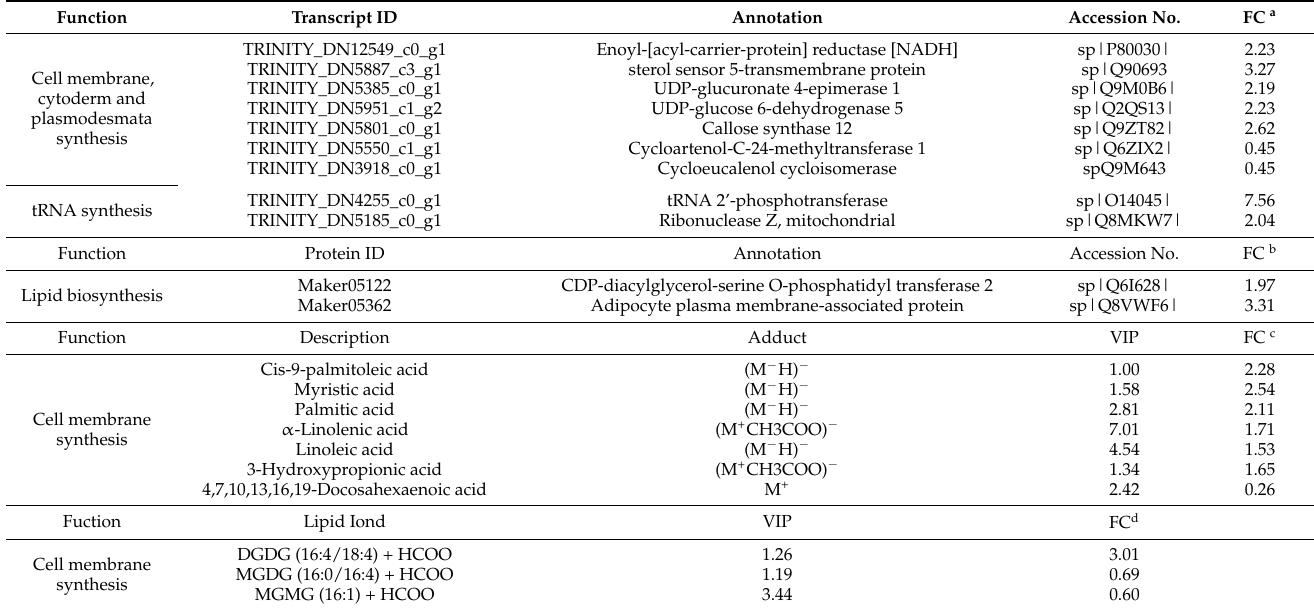
Table 7. Fluctuation of molecules in U. prolifera on cell membrane synthesis and repair after 12 h treatment with high